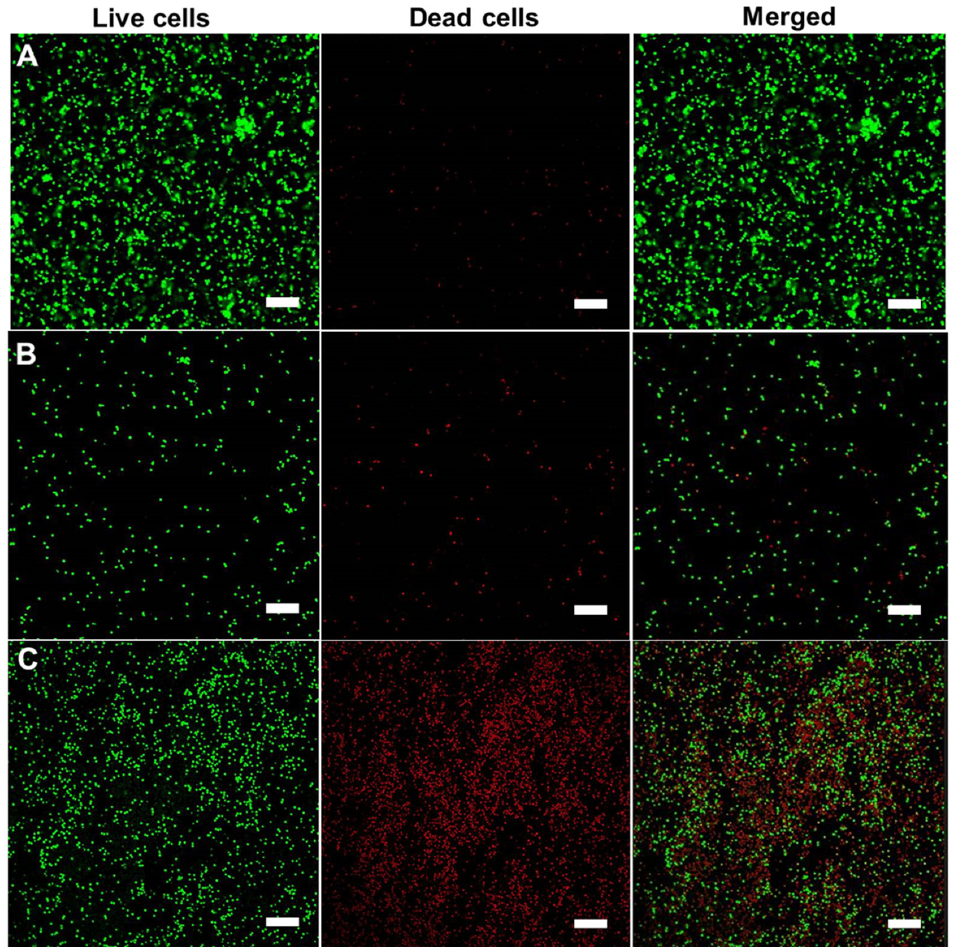
Figure 8. Live/dead cell staining of S. aureus biofilms under different treatment: control preformed biofilm ( A ), preformed biofilm treated with bare Fe 3 O 4 NPs ( B ) and preformed biofilm treated with Fe 3 O 4 @PDA HR ( C ) under rotational magnetic field (Scale bar = 10 μ m).